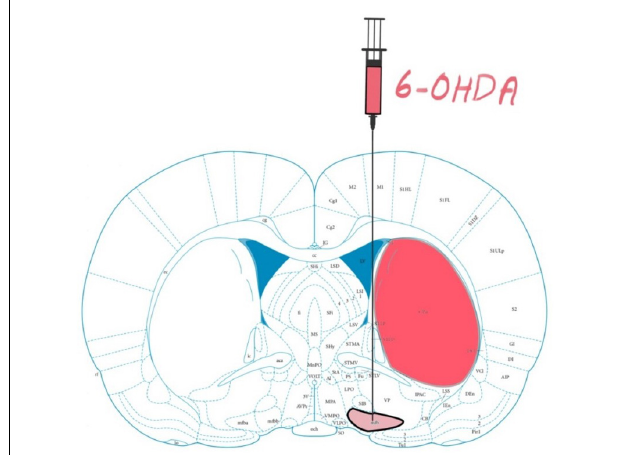
FIGURE 1 | Rat brain atlas; 6-hydroxydopamine (6-OHDA) Parkinson’s Disease (PD) models are made by administering 6-OHDA into nigrostriatal pathway, in this case the medial forebrain bundle (mfb). From 6-14 days post lesioning, the dopaminergic cells in the striatum (Caudate Putamen CPu) degenerate. Figure adapted from Mottaghi (2020).